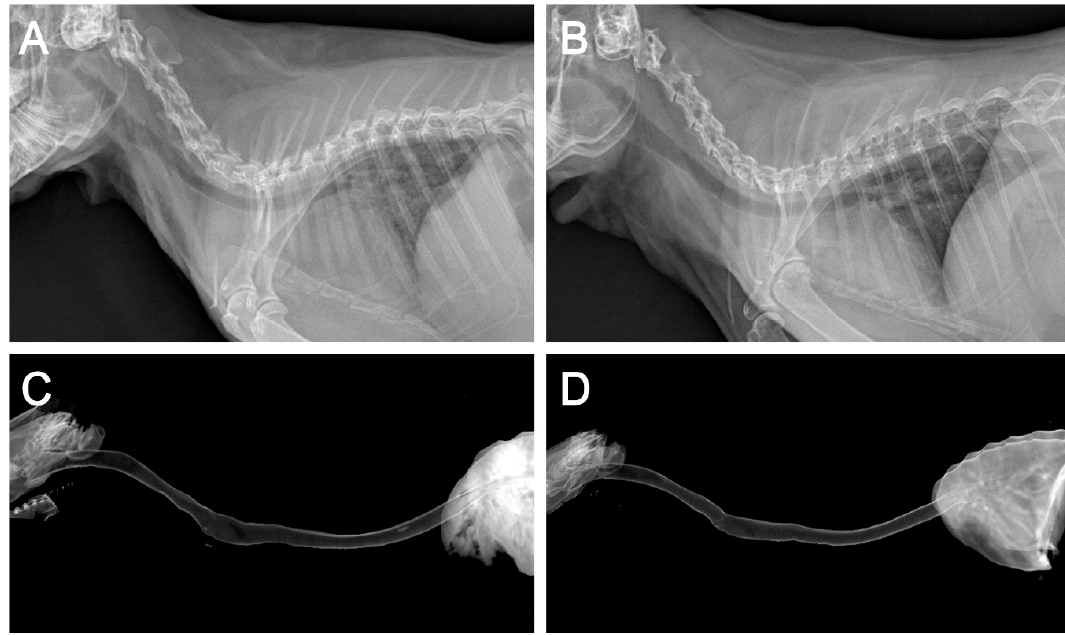
Figure 4. Radiographic findings. Plain lateral thoracic view of the MSC ( A ) and d-MSC ( B ) groups